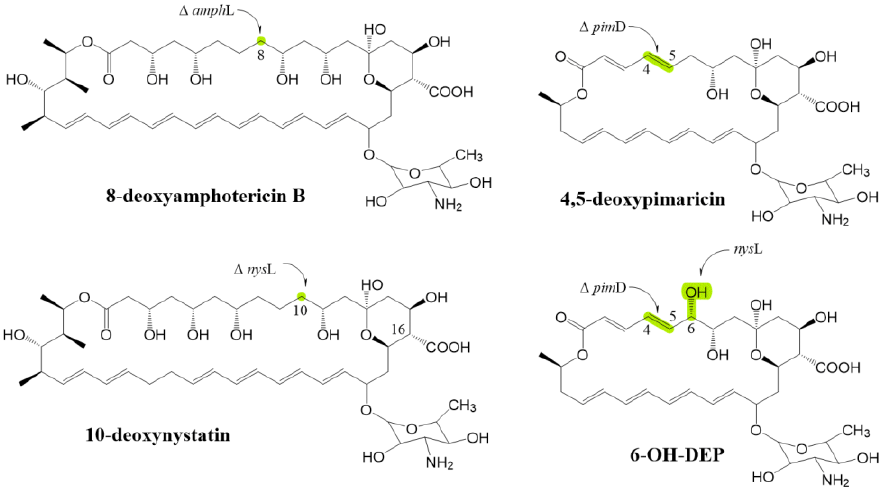
Figure 8. Structure of polyene macrolide derivatives related to hydroxyl; highlights represent differences from the initial compound. 6-OH-DEP is 6-hydroxy-desepoxypimaricin. Santos [55] explored the substrate-recognition specificity of CYP450 enzymes, such as NysL, and integrated homologous genes, such as amph L, nys L, and tetr K (transforming tetramycin A into tetramycin B), into S. natalensis 6D4 to explore whether their encoding products can catalyze the epoxidation or hydroxylation of 4,5-deoxypimaricin. Except for AmphL, CYP450 enzymes can recognize 4,5-deoxypimaricin and produce 6-hydroxy- desepoxypimaricin (6-OH-DEP; see Figure 8) and pimaricin. However, their catalytic efficiency is low. NysL can convert 23% (156 ± 21 µ g/mL) of 4,5-deoxypimaricin into 6-OH-DEP, whereas TetrK can convert only 18% (89 ± 9 µ g/mL) of 4,5-deoxypimaricin into pimaricin. This result indicates an imperfect active site recognition. The nys L was placed under the control of a double promoter combining the pim D and erm E* promoters into pIB139. This method can improve the catalytic efficiency of NysL to 48% (341 ± 64 µ g/mL); they deduced the reasons why the catalytic efficiency of the two CYP450 enzymes are lower than PimD. First, the catalytic efficiency of the two enzymes is different. Second, for TetrK, the efficiency of catalytic epoxidation is extremely low. As for NysL, the differential substrate size is not conducive to NysL recognition, and NysL may interact positively with a substrate. The antifungal activity results show that the MIC 50 values of the 6-OH-DEP and 4,5-deoxypimaricin are 47.1 µ g/mL, which is 15 times that of pimaricin. In addition to the experiment on the modification of nys L of Volokhan [56], the antifungal activity and hemolytic activity of the de-epoxidation or decarboxylation-modified derivatives of other reported polyene macrolides are lower than those of the corresponding starting antibiotic molecules. That is, the chemical structures of the polyol region of these antibiotics are crucial to their ability to interact with membrane ergosterol or cholesterol. According to the polyene ion channel model, the polyol region of polyene macrolides is in the ion channel. The change of hydrophilic groups in the polyol region not only affects the characteristics of the ion channel but also affects the hydrogen bond network within an antibiotic molecule and the conformation of the antibiotic molecule, thus affecting the pharmacological properties of polyene macrolides. In addition, the second type of CYP450 monoox- ygenase has relatively high catalytic specificity. For example, AmphL cannot recognize amphotericin B in the absence of glycosyl modification. By contrast, NysL and TetrK seem to be much less specific than AmphL. Although NysL cannot identify the correct position after changes in the C9 – C10 region of the nystatin precursor, it can still catalyze. NysL and TetrK can catalyze a small amount of other polyene macrolide precursors. These re- sults reflect that the substrate-recognition specificity of some homologous CYP450 monooxygenases is not as high as expected.